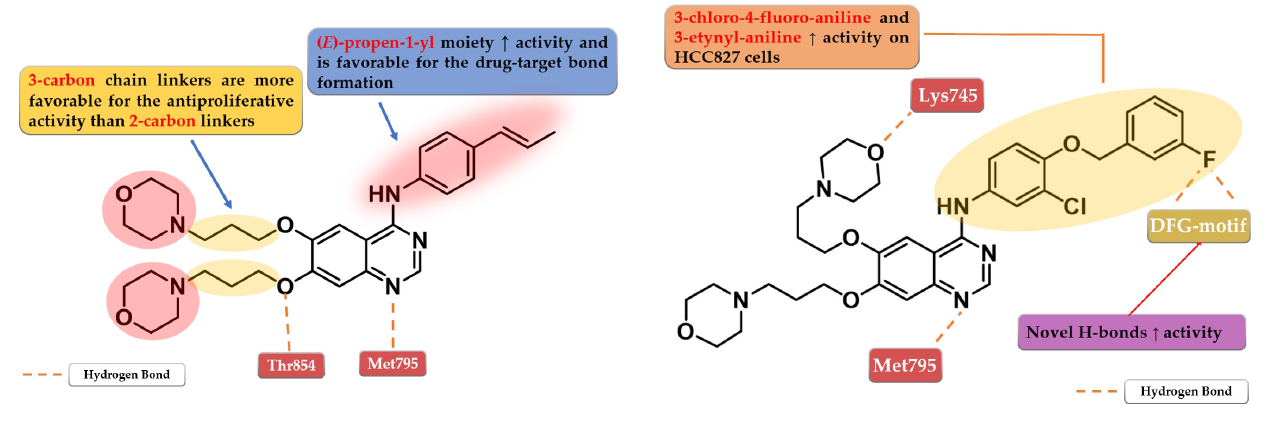
Figure 3. Structure–activity relationship and molecular docking of compound 1 in the human EGFR kinase domain (PDB ID 1XKK) [101], as reported by Chen et al. [104]; structure–activity relationship and molecular docking of compound 2 in the human EGFR kinase domain (PDB ID 1XKK) [101], as reported by Zhang et al. [105].